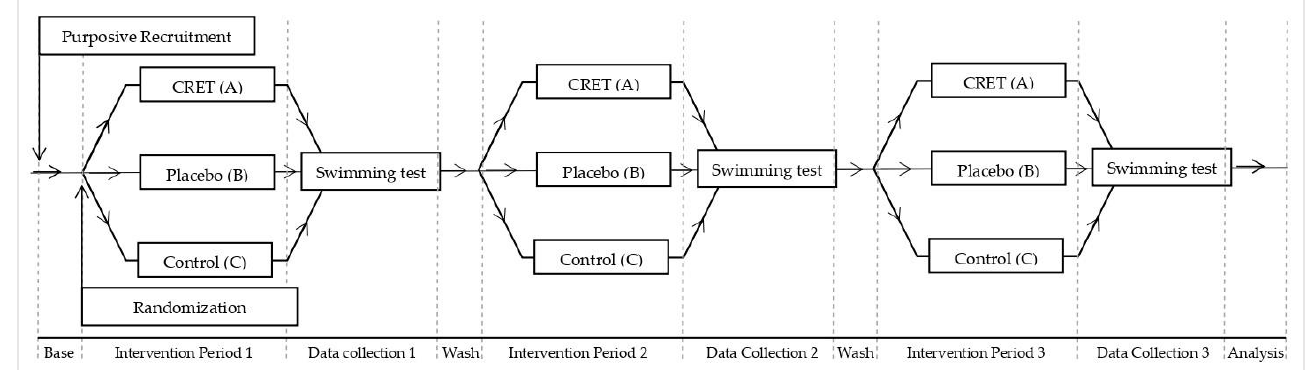
Figure 2. Experimental design. Source: Own elaboration.